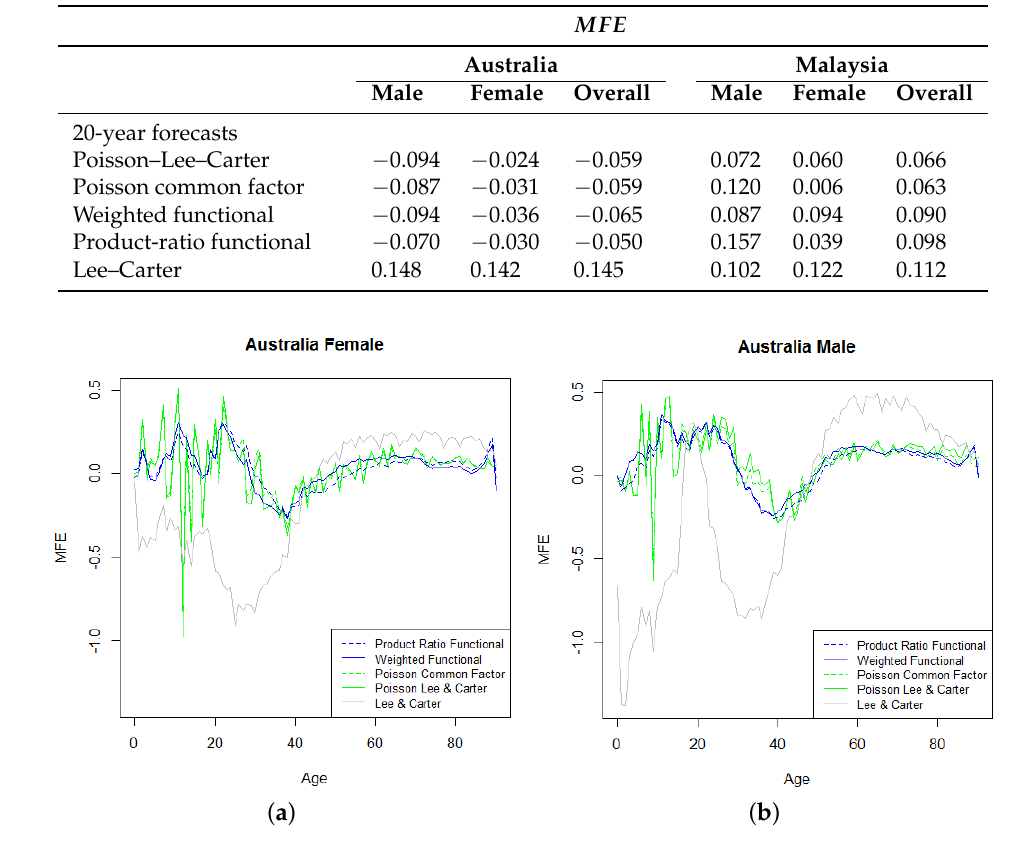
Table 2. Mean Forecast Error ( MFE ) of log death rates for males and females by method, gender and country.